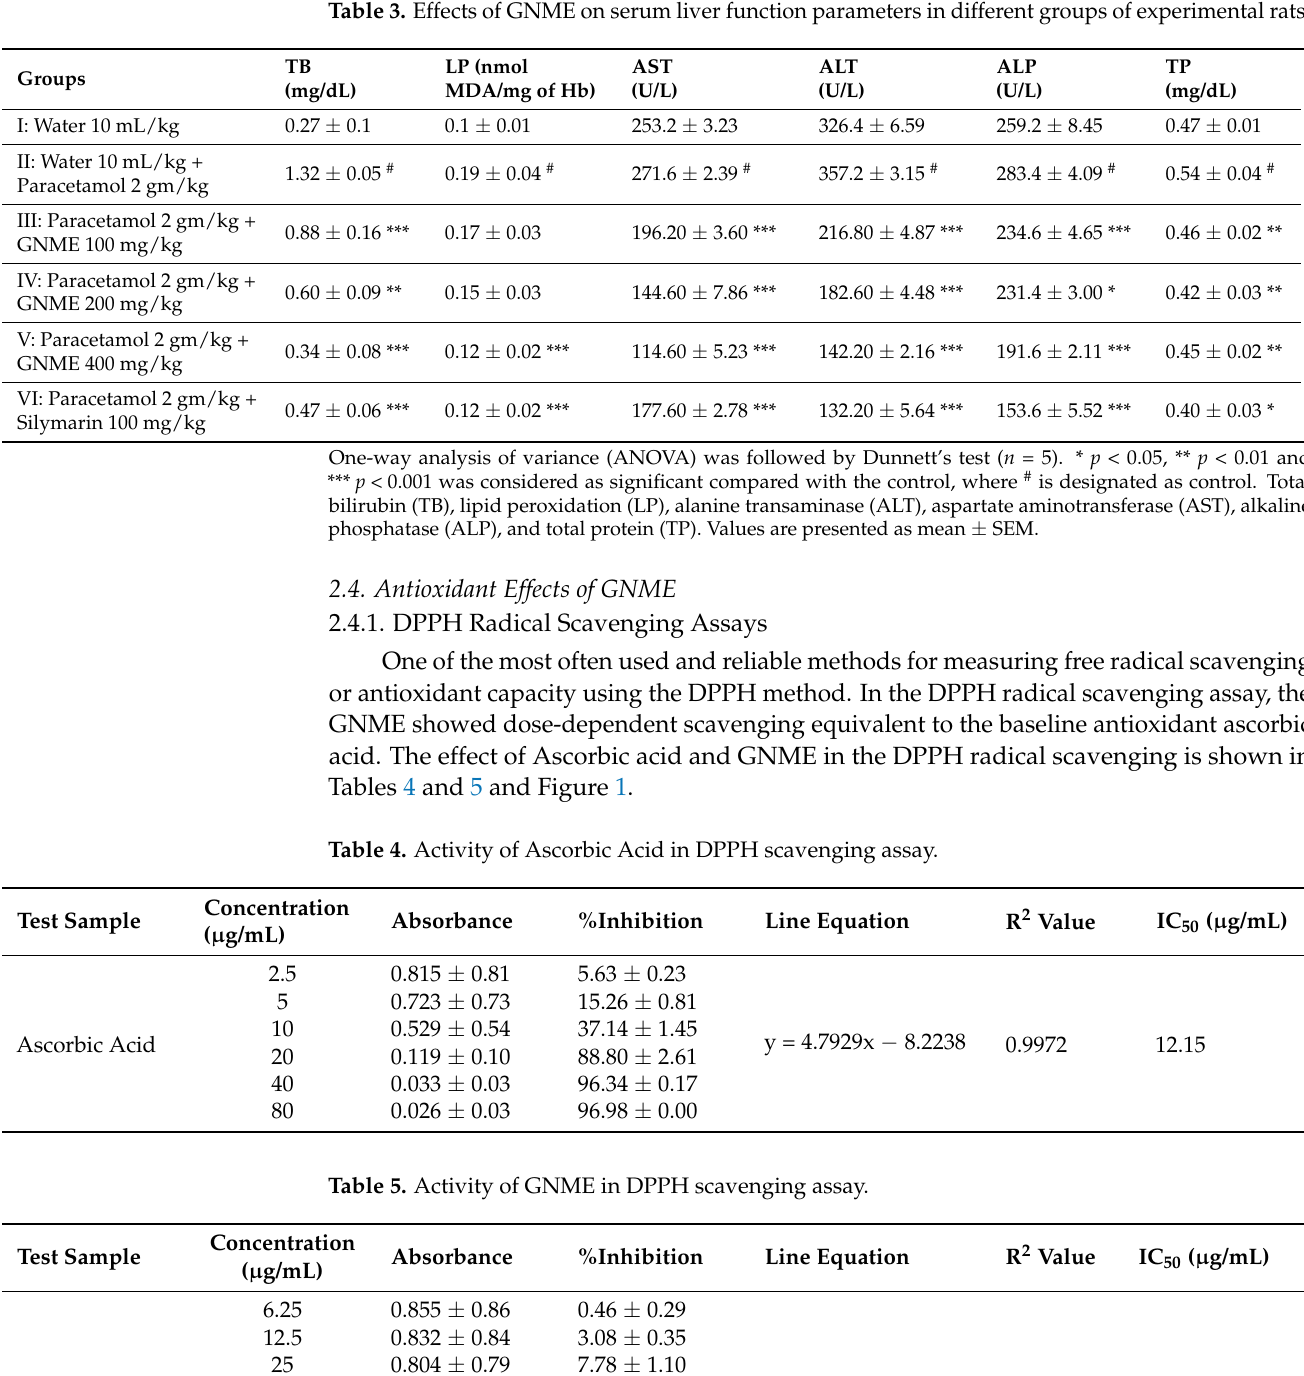
Table 3. Effects of GNME on serum liver function parameters in different groups of experimental rats.